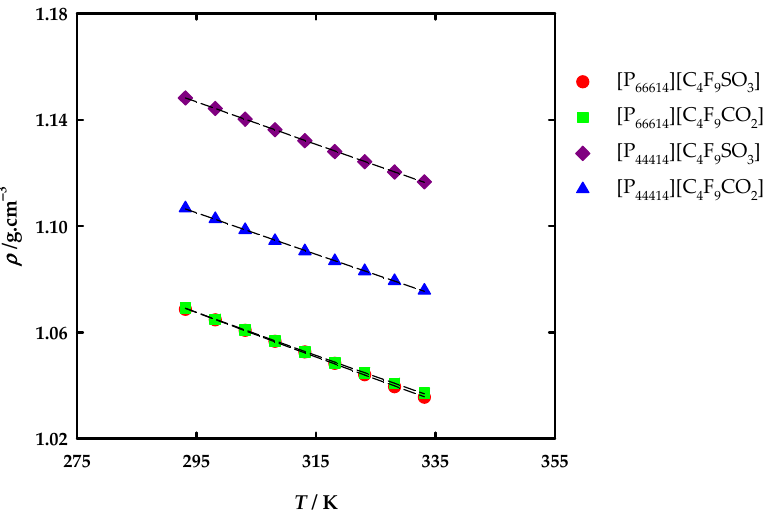
Figure 1. Density values as a function of temperature ( T ) and fitted curves for the synthesized fluorinated ionic liquids.